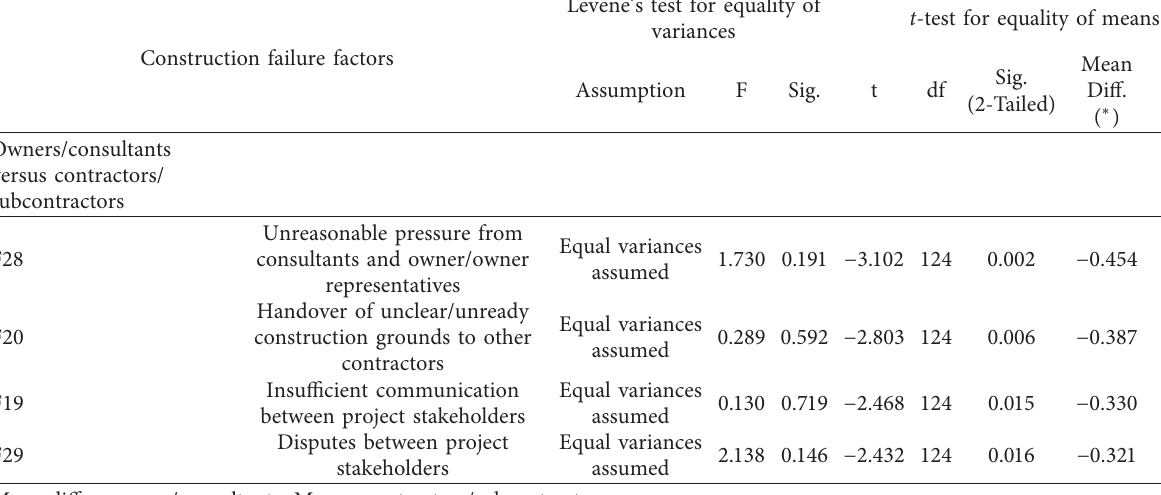
Table 4: Factors with significant different construction failure perceptions of groups under t-